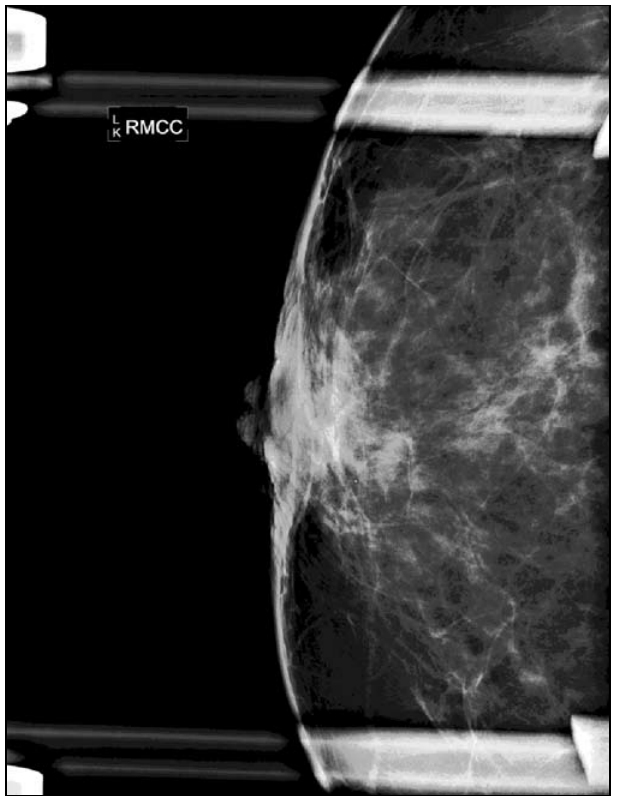
Fig. 1. Right cranio-caudal mammogram.